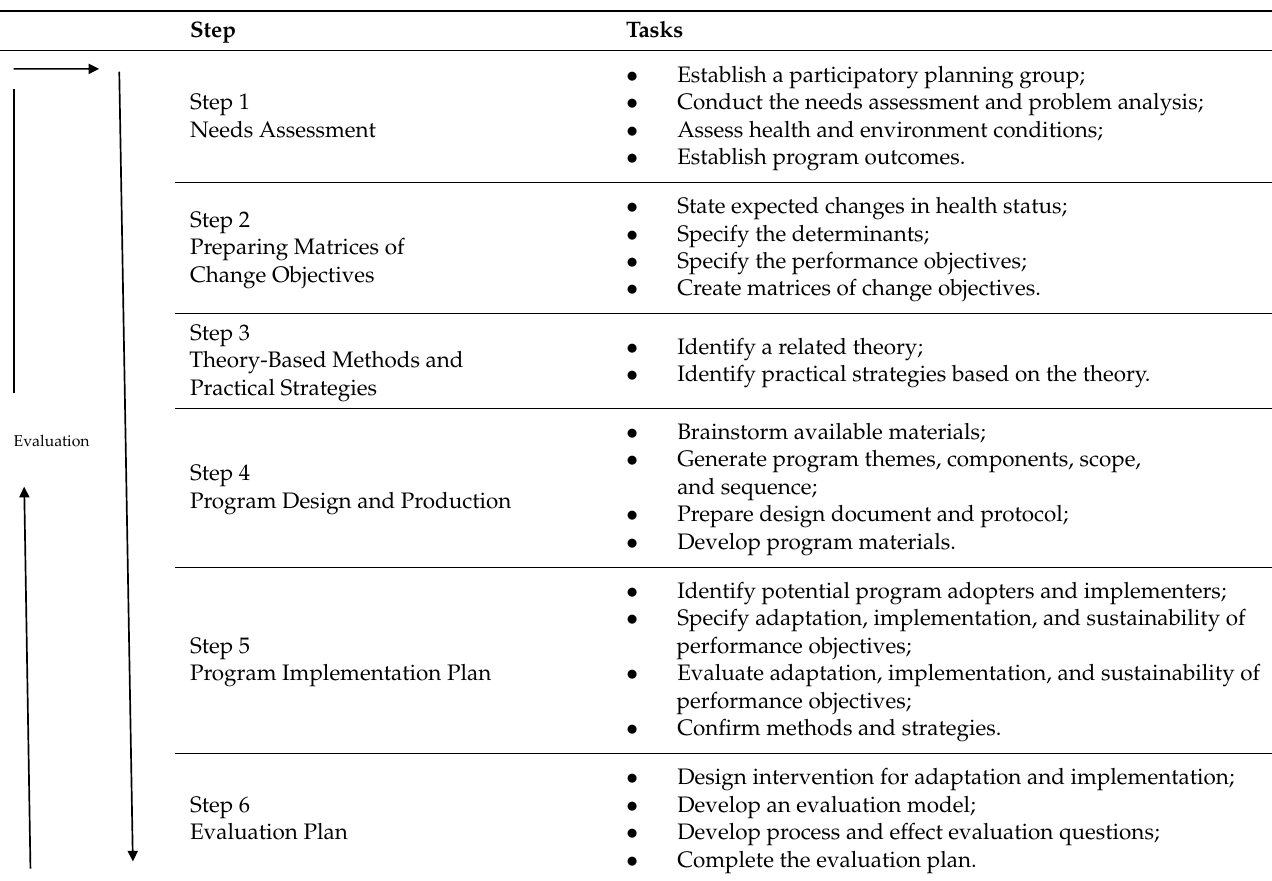
Table 1. Steps of the intervention mapping framework.